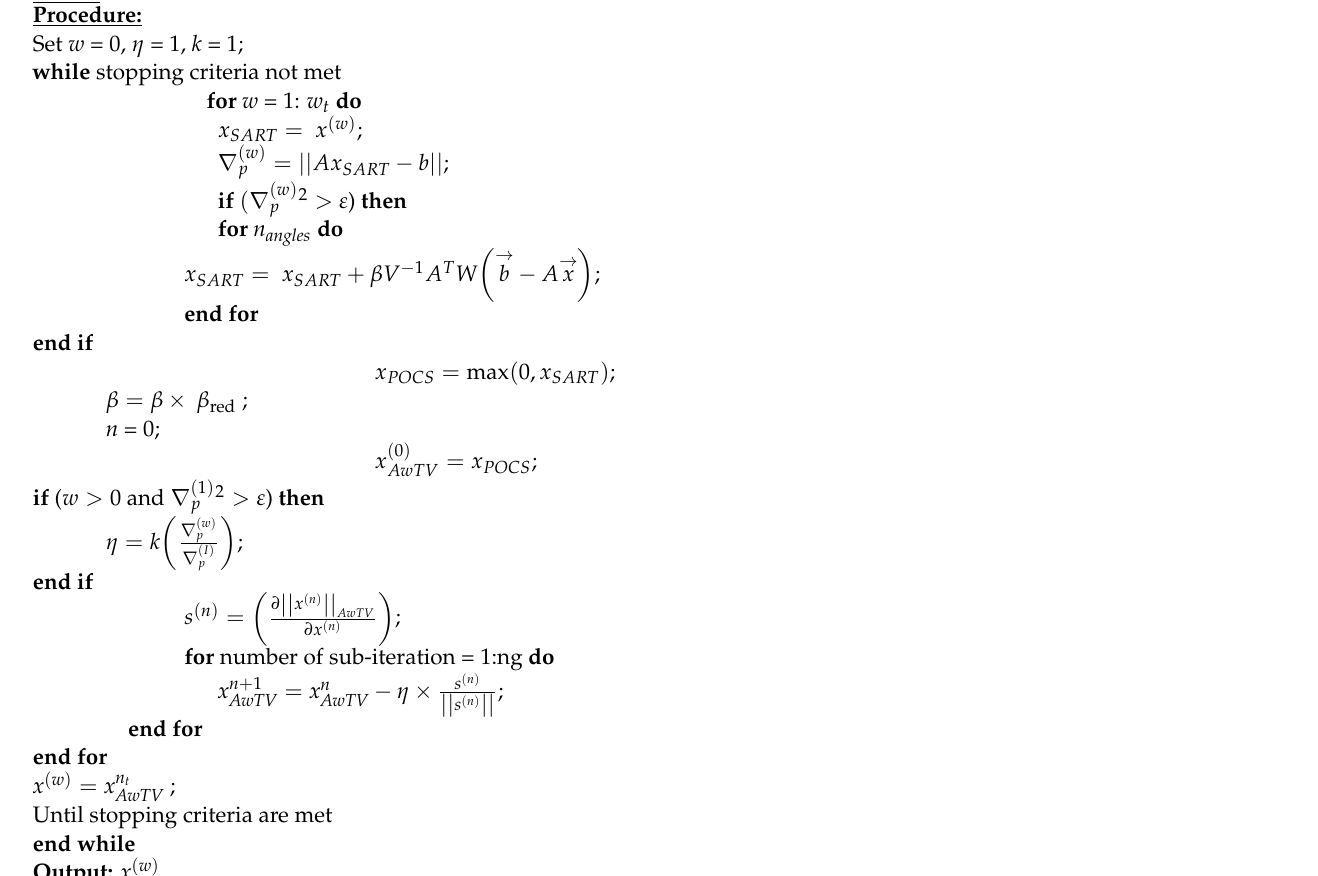
Algorithm 1: Pseudo code for the Adaptive-weighted Projection-Controlled Steepest Descent (AwPCSD) algorithm Inputs: x 0 , β , β red , ε , ng , δ